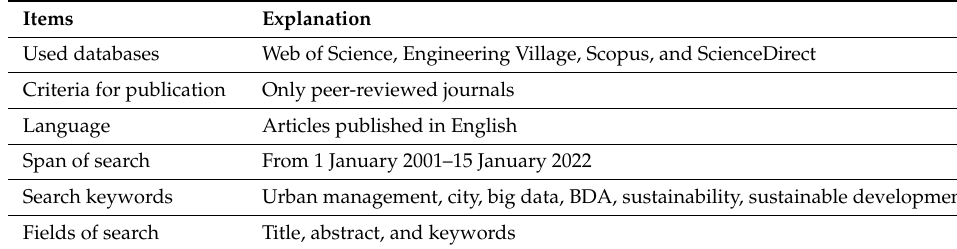
Table 1. Summary of the research